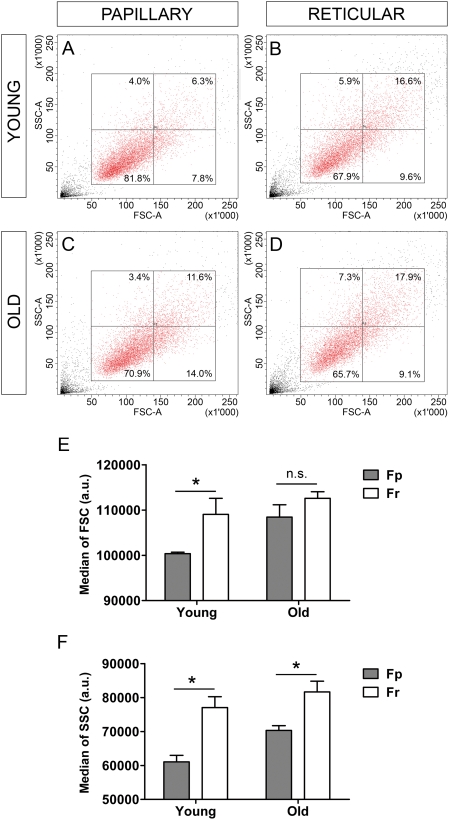
Evolution with age of Fp and Fr morphology.Fp and Fr samples from 3 young donors (19 yr, 21 yr, and 26 yr) and 3 old donors (57 yr, 62 yr, and 74 yr) were examined by flow cytometry according to the morphological parameters of size (forward scatter, FSC) and granularity (side scatter, SSC). FSC versus SSC dot plots corresponding to a typical pair of young [19 yr] Fp (A) and Fr (B), and a typical pair of old [74 yr] Fp (C) and Fr (D). Median FSC and SSC values were determined for the different samples. (E) Comparison of Fp and Fr FSC values in young and old donors (mean±SEM, n = 3). (F) Comparison of Fp and Fr SSC values in young and old donors (mean±SEM) (*p<0.05; n.s. = not significant). a.u. = arbitrary unit.